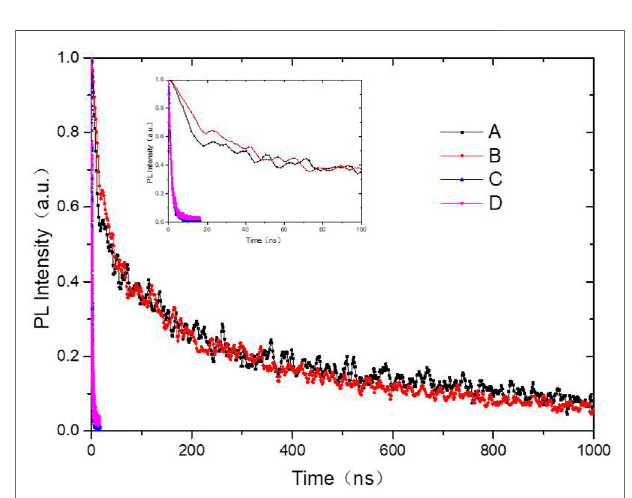
FIGURE 4 | TRPL decay spectra of samples A, B, C, and D.